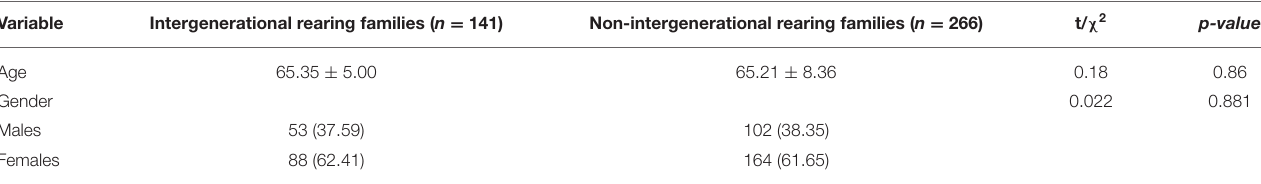
TABLE 1 | Socio-demographic data from the participant grandmothers. n (%).